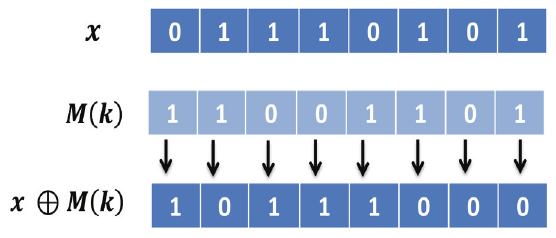
Fig. 1. Given the current mask M ( k ) and a solution x , the objective function is applied to f ( x ⊕ M ( k )) , where ⊕ is the XOR (exclusive OR)